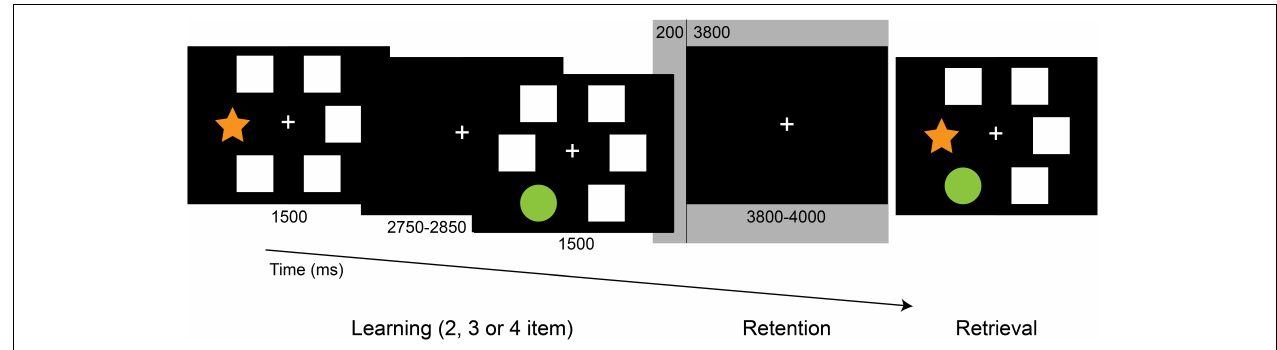
FIGURE 1 | The Paired Associates Learning (PAL) task. Following the memory sequence, participants indicated, whether the shapes appeared in the previously presented positions. Epochs of 4,000 ms duration of the retention period (from 200 ms pre-stimulus to 3,800 ms post-stimulus, highlighted) were included in the